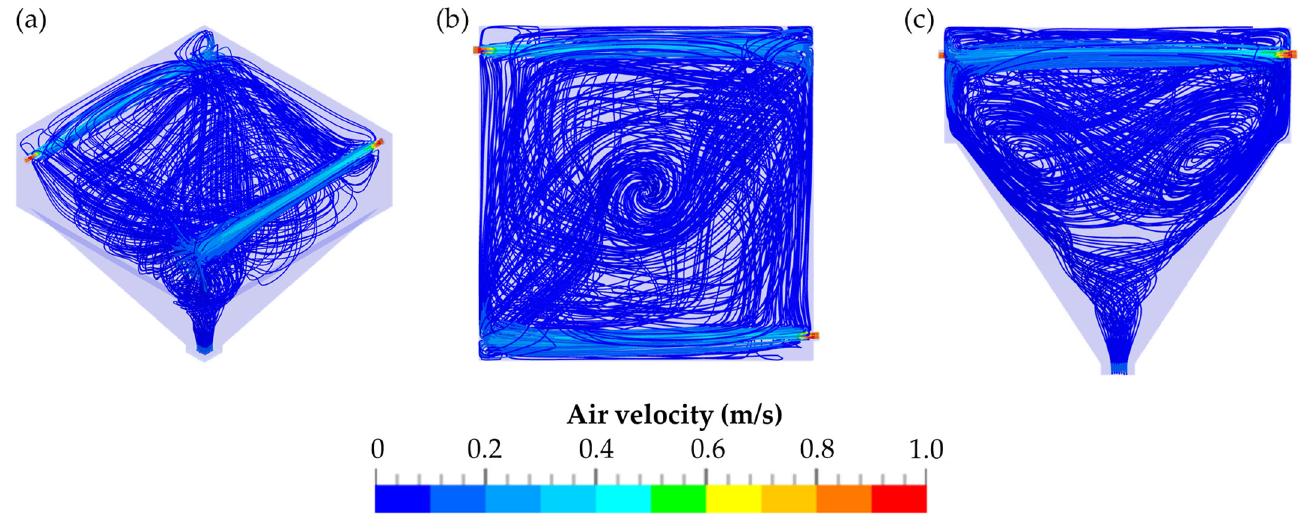
Figure 9. Particle trace analysis of the detection chamber during evacuation: overview of the TCS ( a ); top view of the TCS ( b ); lateral view of the TCS ( c ).